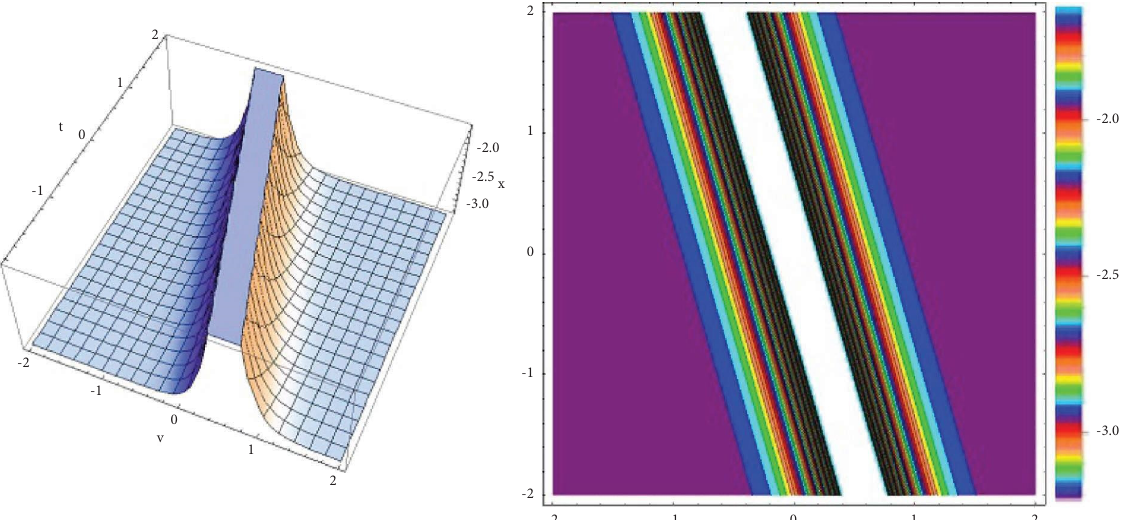
Figure 5: Singular bell shape soliton drawn from (13) for. ω � 3 . 43.